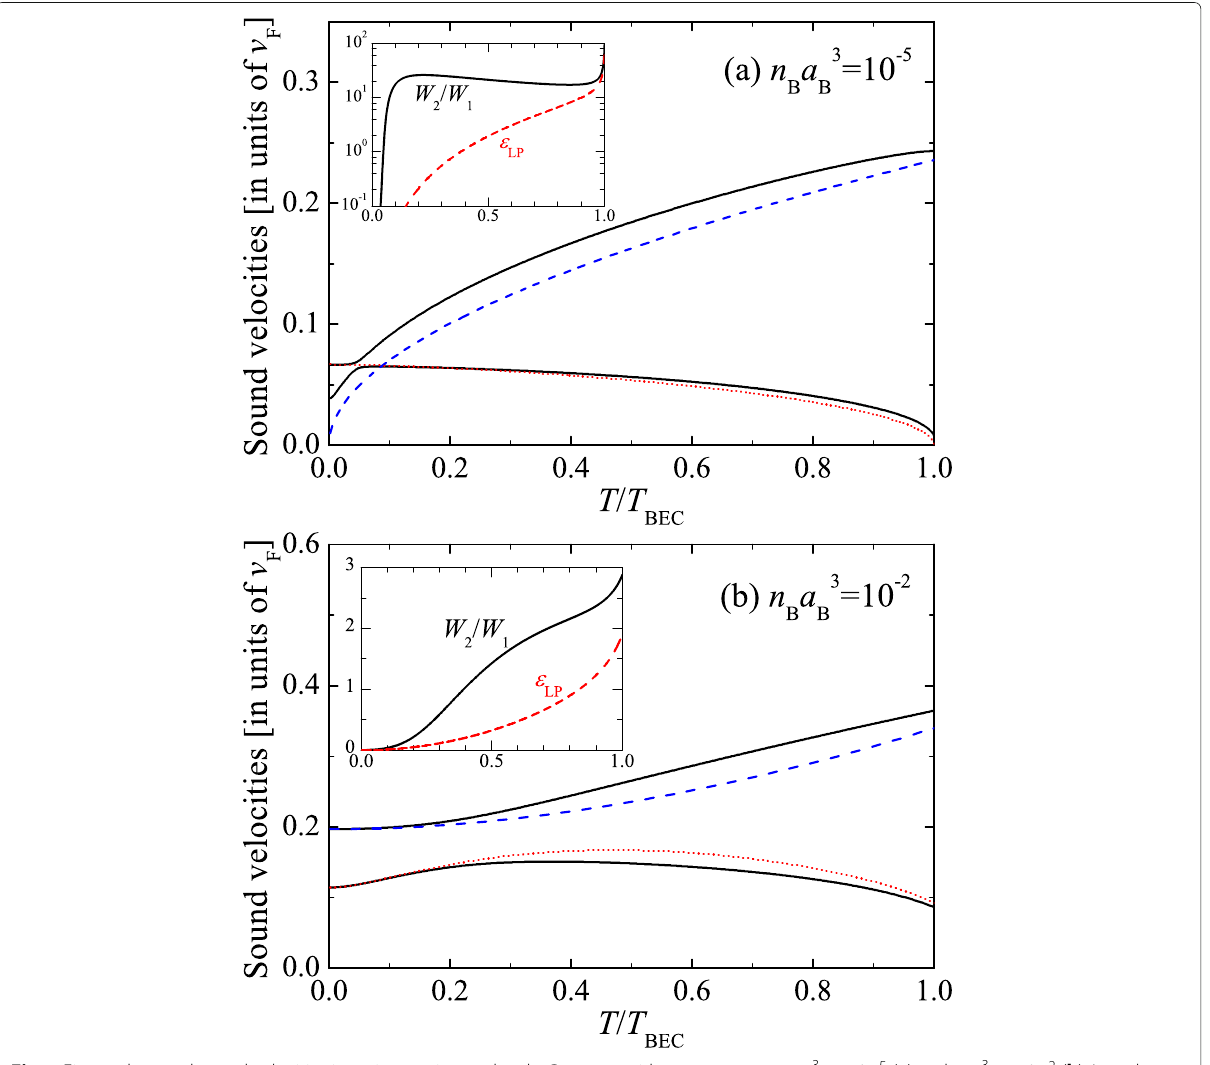
= 10 − 5 ( a ) and n = 10 − 2 ( b ). In a , the 3 √ B a B B c P / c V .